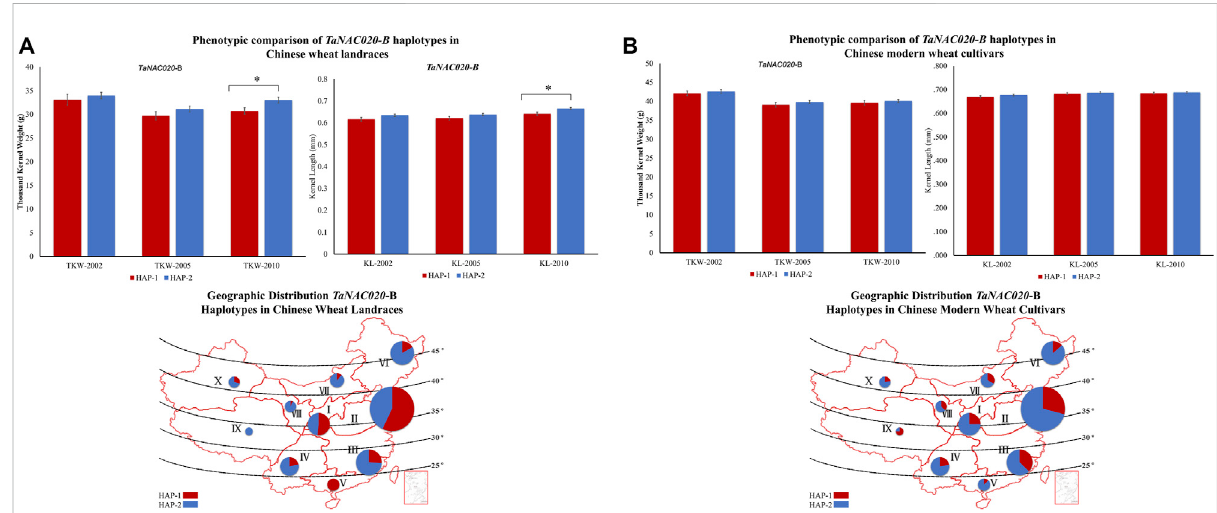
FIGURE 5 Phenotypic comparison of TaNAC020-B haplotypes and their distribution in 10 Chinese major wheat production zones. (A) Phenotypic comparison and geographic distribution of haplotypes in Chinese wheat landraces. (B) Phenotypic comparison and geographic distribution